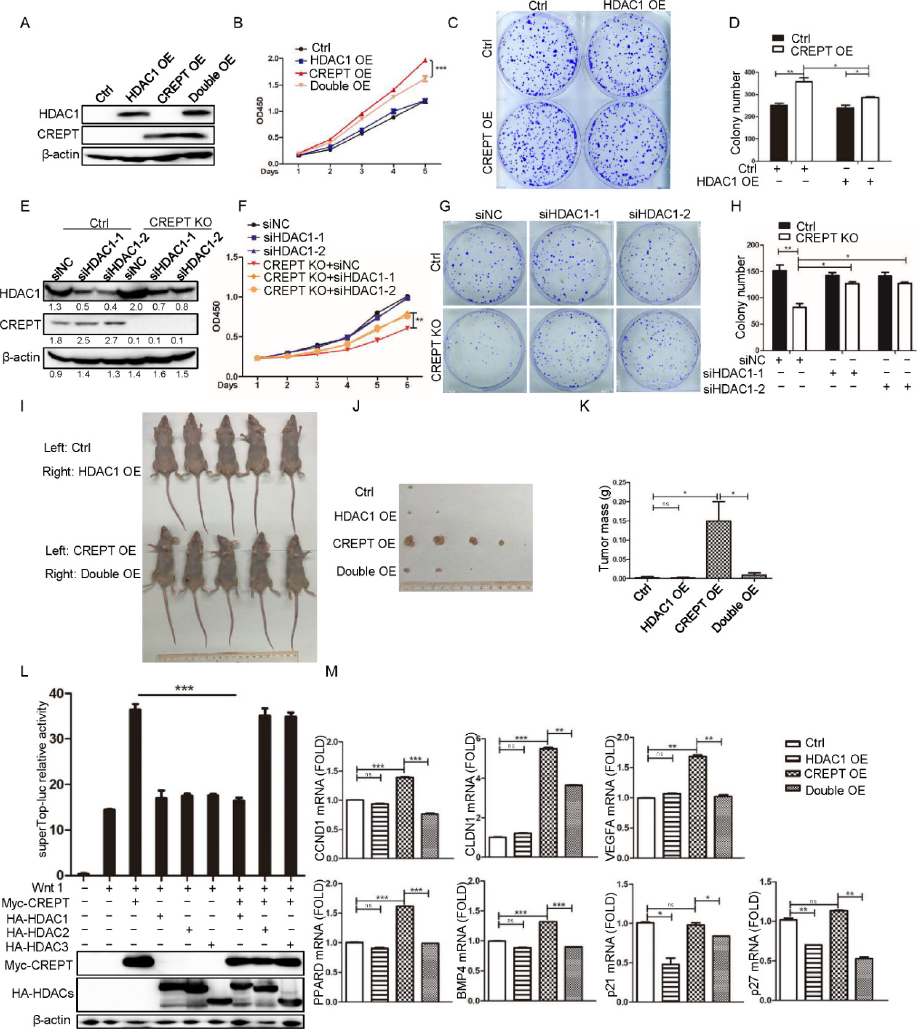
Figure 2. HDAC1 represses the activity of CREPT in promoting tumorigenesis. Stable cell lines were established for the overexpression of HDAC1 (HDAC1 OE) alone, CREPT (CREPT OE) alone, and both HDAC1 and CREPT (HDAC1&CREPT OE) in DLD1 cells, as well as for the deletion of HDAC1 (siHDAC1) or deletion of CREPT (CREPT KO) in SW480 cells. An empty vector was used as a control (EV) for overexpression experiments in DLD1 cells and a non-specific siRNA (siNC) was used as a control for deletion experiments in SW480 cells. Indicated stable cell lines were cultured for the CCK8 experiment at different days. A colony formation experiment was performed. A statistic result for the colony numbers as scanned by Image J is presented on the right panel. ( A – D ). Ectopic expression of HDAC1 significantly inhibits cell proliferation ( A , B ) or colony formation ( C , D ) in the presence of overexpressed CREPT in DLD1 cells. ( E – H ). Knocking down the expression of HDAC1 elevates cell proliferation ( E , F ) or colony formation ( G , H ) in the absence of CREPT in SW480 cells. The bands were quantified using ImageJ and presented as a value normalized according to the moderate level of a band in each blot. ( I – K ). Overexpression of HDAC1 inhibits the tumor formation in the presence of overexpressed CREPT by Lovo cells in nude mice. ( L ). HDAC1 blocks the activity of CREPT in regulating the Wnt signaling pathway. Super-TOP-luciferase reporter (0.1 µ g), pRL-TK (50 ng), HA–HDACs (0.1 µ g) and Myc–CREPT (0.4 µ g) were co-transfected into HEK293T cells. Luciferase activity is presented as a relative value based on the internal control (renilla signal). ( M ). HDAC1 inhibits the expression of CREPT-activated genes. The mRNA levels of CCND1, CLDN1, VEGFA, BMP4, PPARD, p21 and p27 were examined in DLD1 cell lines. (ns, not significantly, * p < 0.05, ** p < 0.01, *** p <